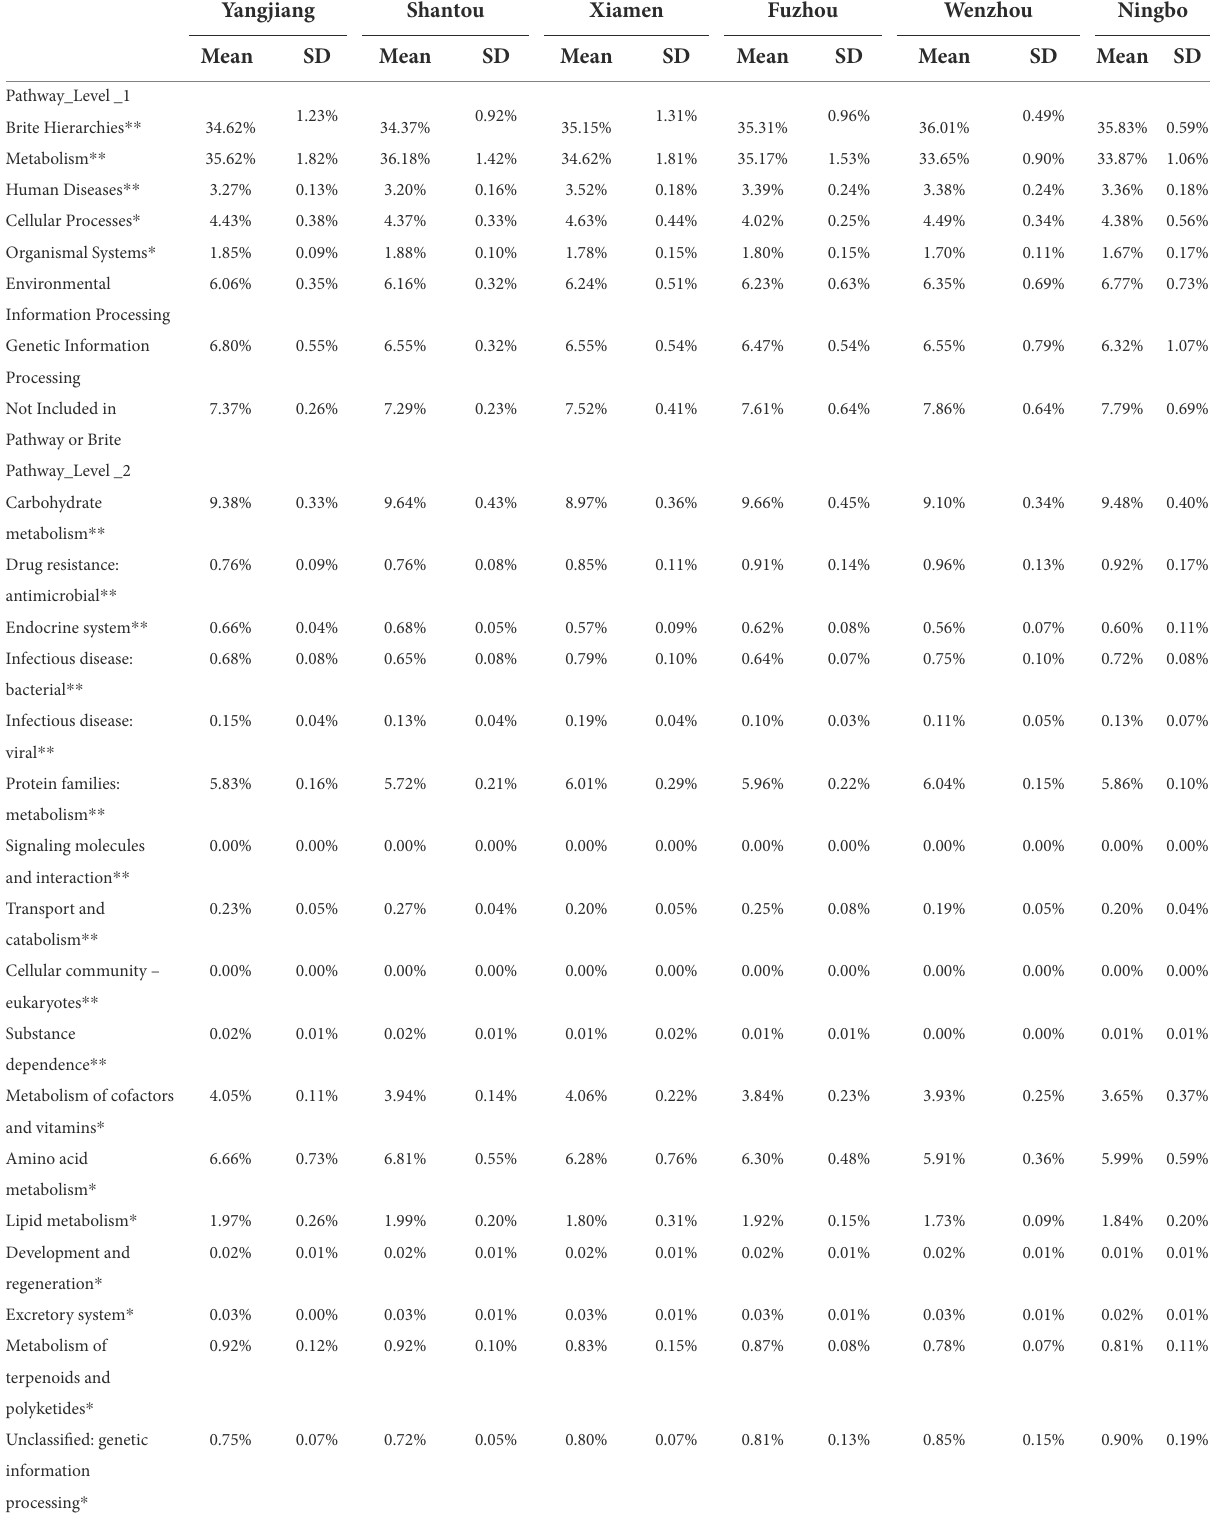
TABLE 2 The proportion of predicted functional profiles in different populations (KEGG Pathway level 1 and level 2). Yangjiang Shantou Xiamen